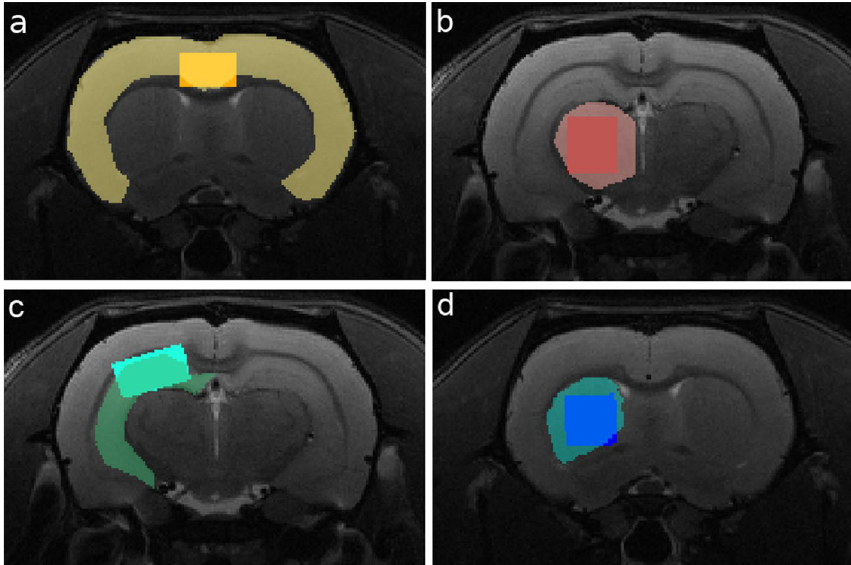
Figure 1. MRS voxel location. Position and size of the four MRS voxels in representative coronal slices of the same animal, overlaid in the respective T2-weighted RARE images and the segmentation of the region of interest: ( a ) cortex; ( b ) right thalamus; ( c ) right hippocampus and ( d ) right